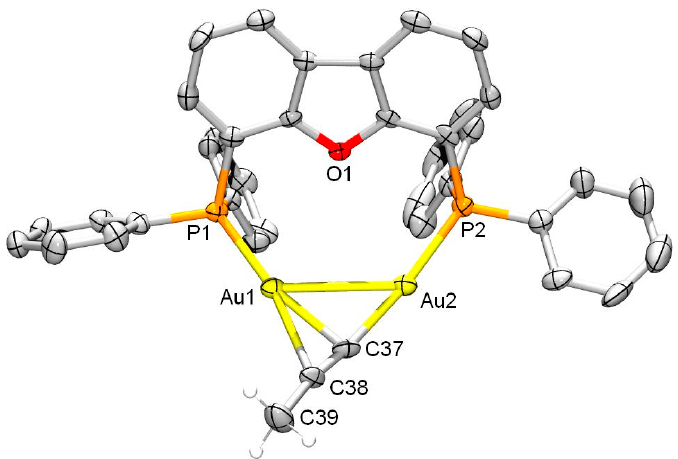
Figure 4. Displacement ellipsoid plot (50% probability level) for 5 , [Au 2 ( µ -CCMe)( κ 2 - P , P -DBFPhos)] + . Two lattice cyclopentane solvent molecules, the SbF 6 counterion and hydrogen atoms, except for those on C39, have been omitted for clarity. Selected bond lengths (Å) and angles (°): P1–Au 2.243(2); P2–